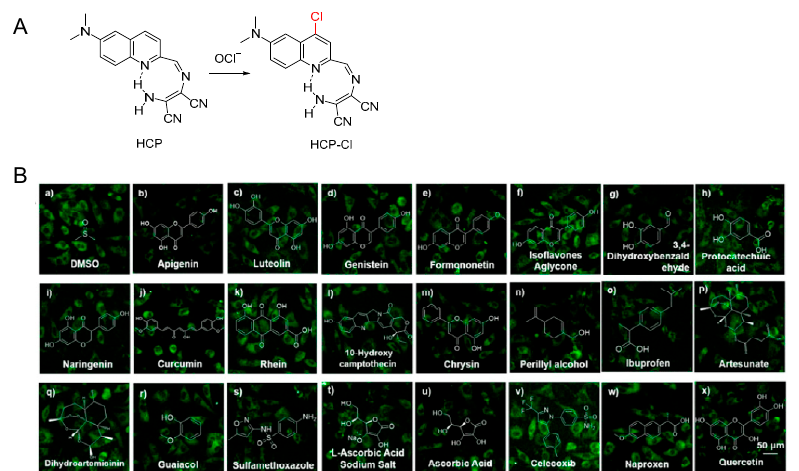
Figure 11. ( A ) Response mechanism of HCP to OCl − . ( B ) High − throughput screening of potential antiepileptic agents from natural products by HCP. Reprinted/adapted with permission from Ref. [67]. Copyright 2020, National Academy of Sciences.